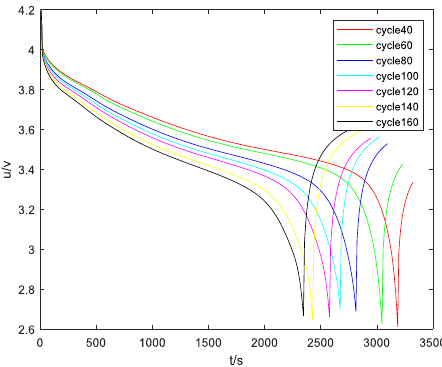
Figure 1. Voltage measurement curve.